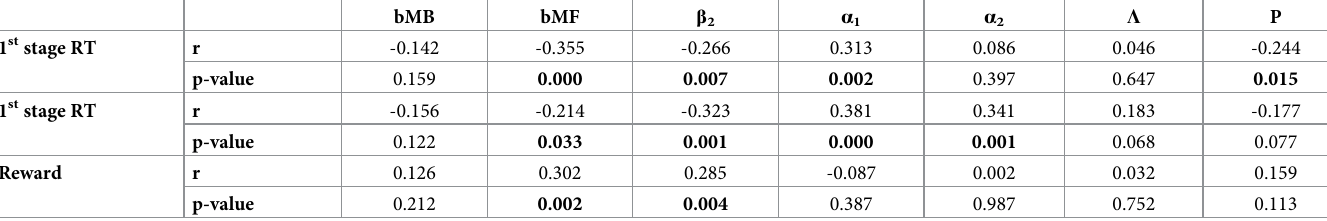
Table 4. Correlation between model parameters with response times and reward rates. Shown are the correlations between the seven parameters (bMB, bMF, β 2 , α 1 , α 2 , λ , p ) with 1 st and 2 nd stage response times (RT) and reward rates as assessed using Pearson product moment